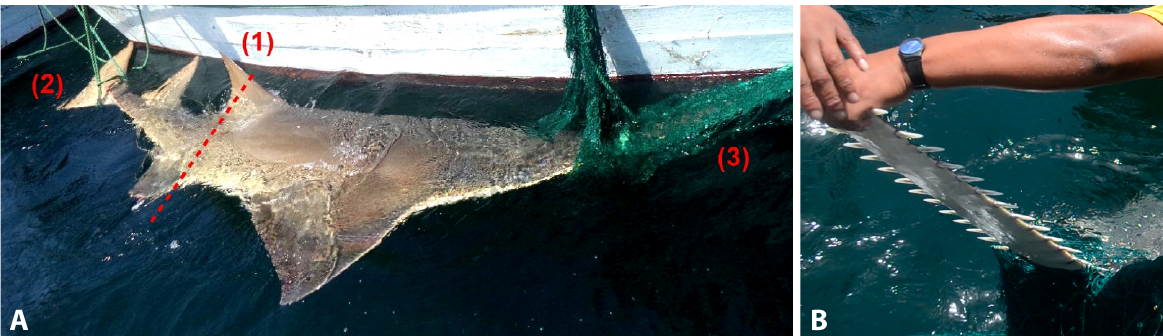
Figure 3 . Sawfish captured on 14 February 2015, taken alive to Cancas, Tumbes and later released. A. Entire specimen showing (1) dorsal fin anterior to the origin of the pelvic fins, (2) the caudal fin, and (3) the rostrum. B. Another view of the